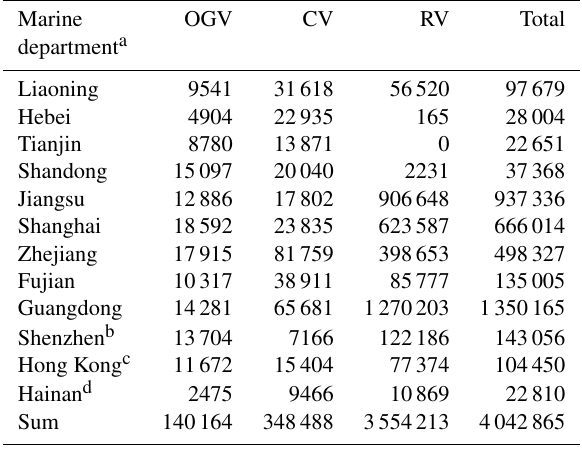
Table 3. Summary of ship calls number by marine department in 2013.